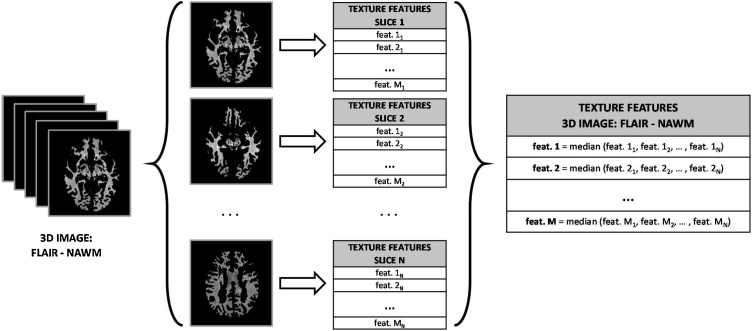
Process followed to extract the 3D features of a FLAIR image of the NAWM. The same process is applied to all the images of each MRI modality (FLAIR, T1W and T2W) and of each tissue/structure (NAWM, WMH and SS).